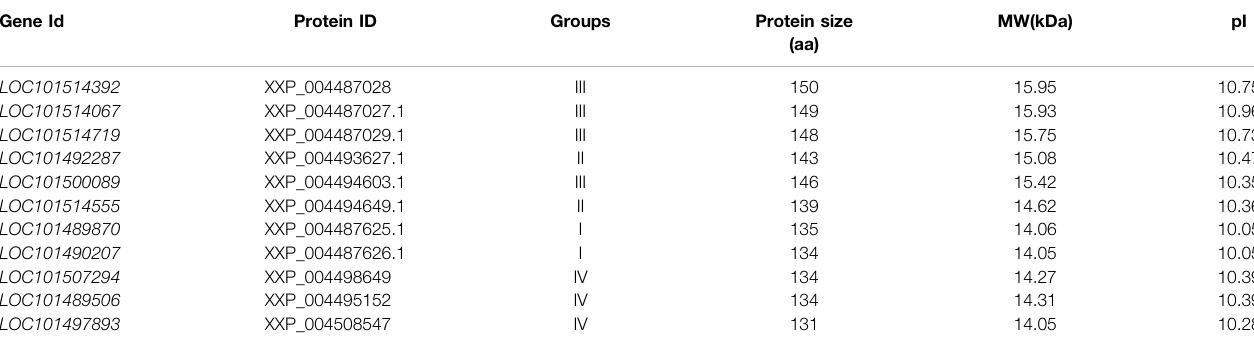
TABLE 2 | Chickpea-speci fi c histone proteins (Chidambaranathan et al., 2016). Gene Id Protein ID Groups